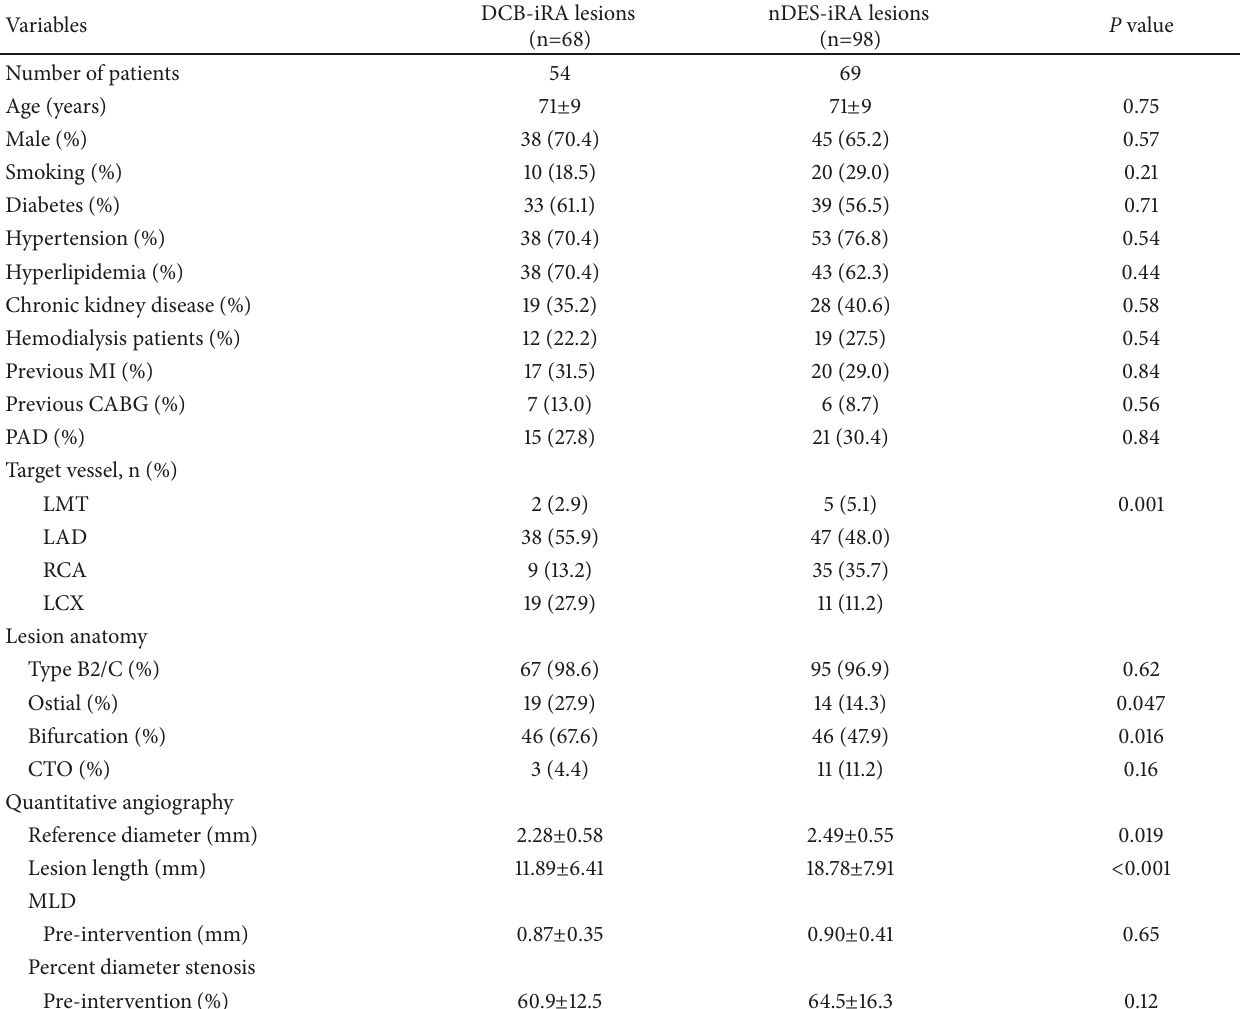
Table 1: Baseline characteristics of patients and